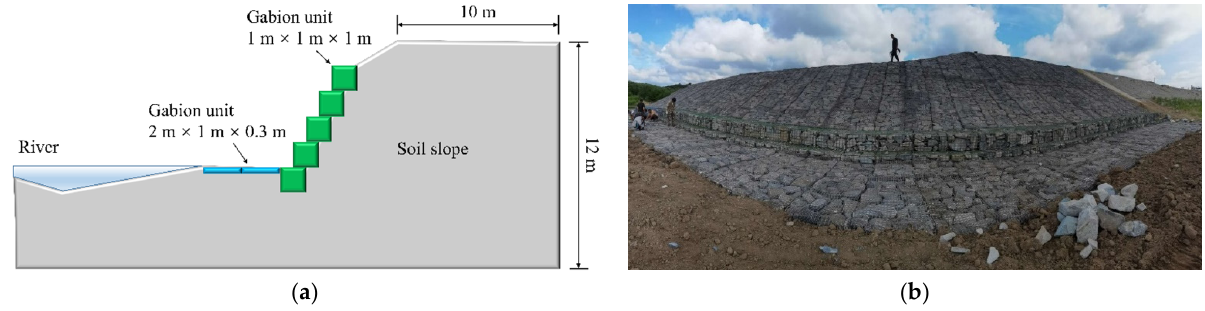
Figure 14. BFR gabion slope. ( a ) Section of the slope. ( b ) Photo of the actual project. According to the gabion slope’s section, the top of the slope extends 6 m to the right, the thickness direction is 3 m, and the height is 8.84 m. The total number of particles is 659,713,